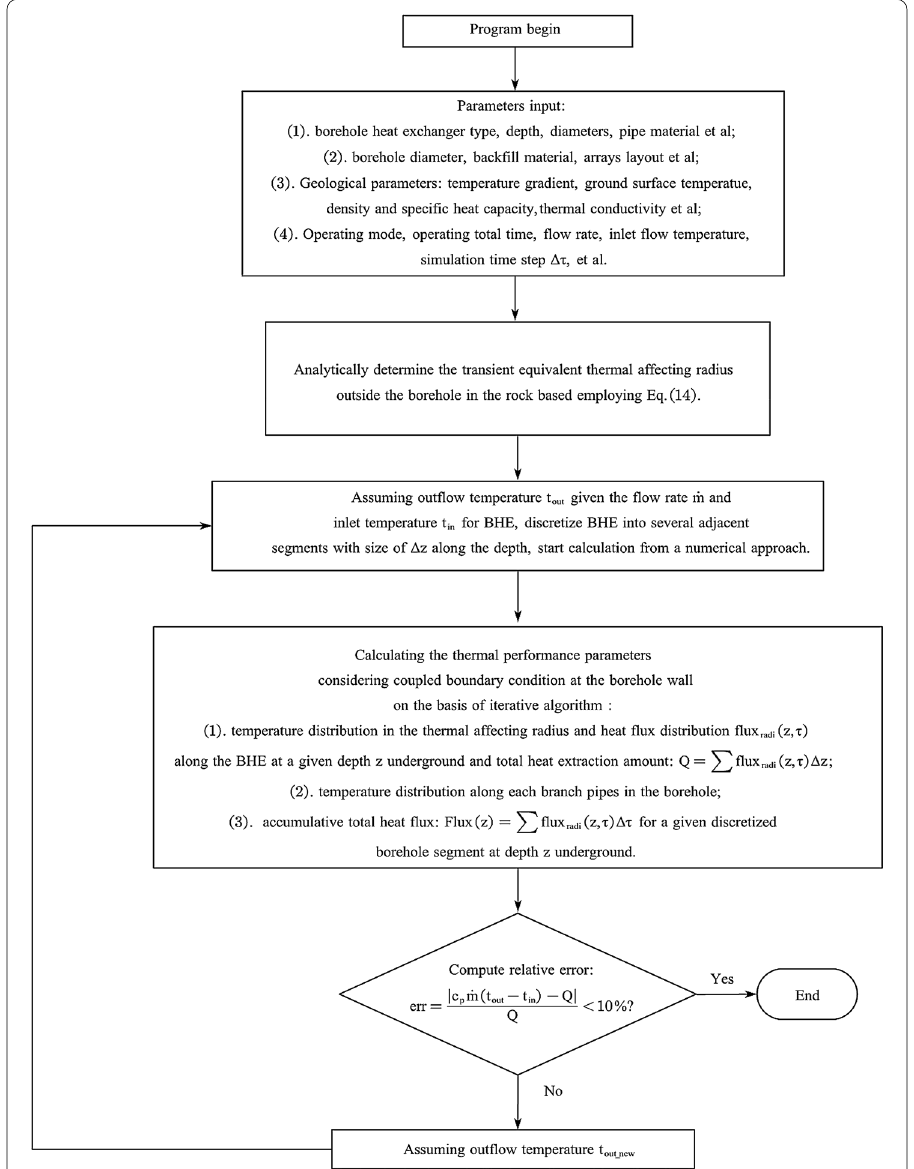
Fig. 7 Flow-chart of calculation procedure and fast simulation strategy for